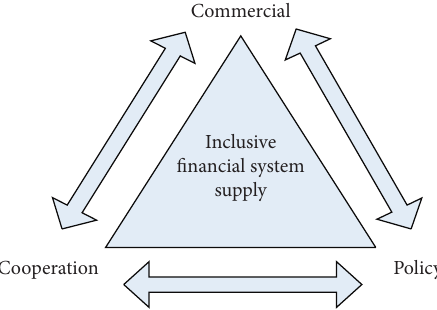
Figure 3: Supply structure of the inclusive financial system.